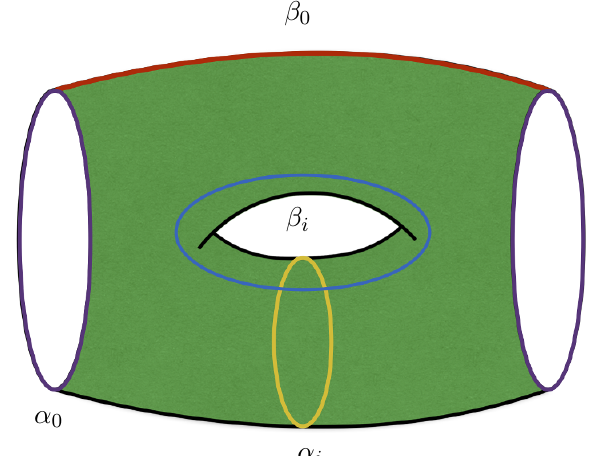
Figure 5 . The fundamental unit T with cycles labeled. Only 1 =n th of (cid:12) 0 is drawn.